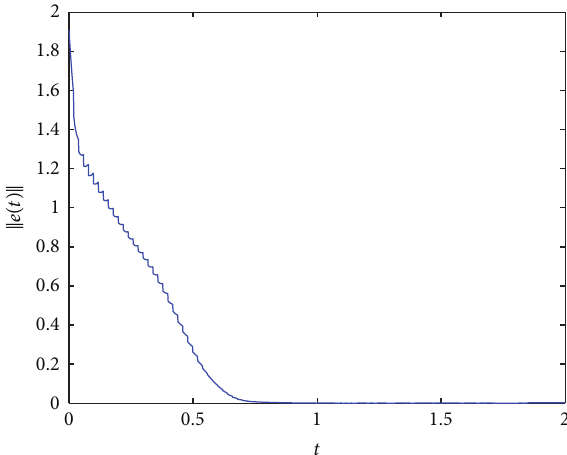
Figure 2: Evolution process of total synchronization error ‖𝑒(𝑡)‖ of two Chua’s circuit networks.